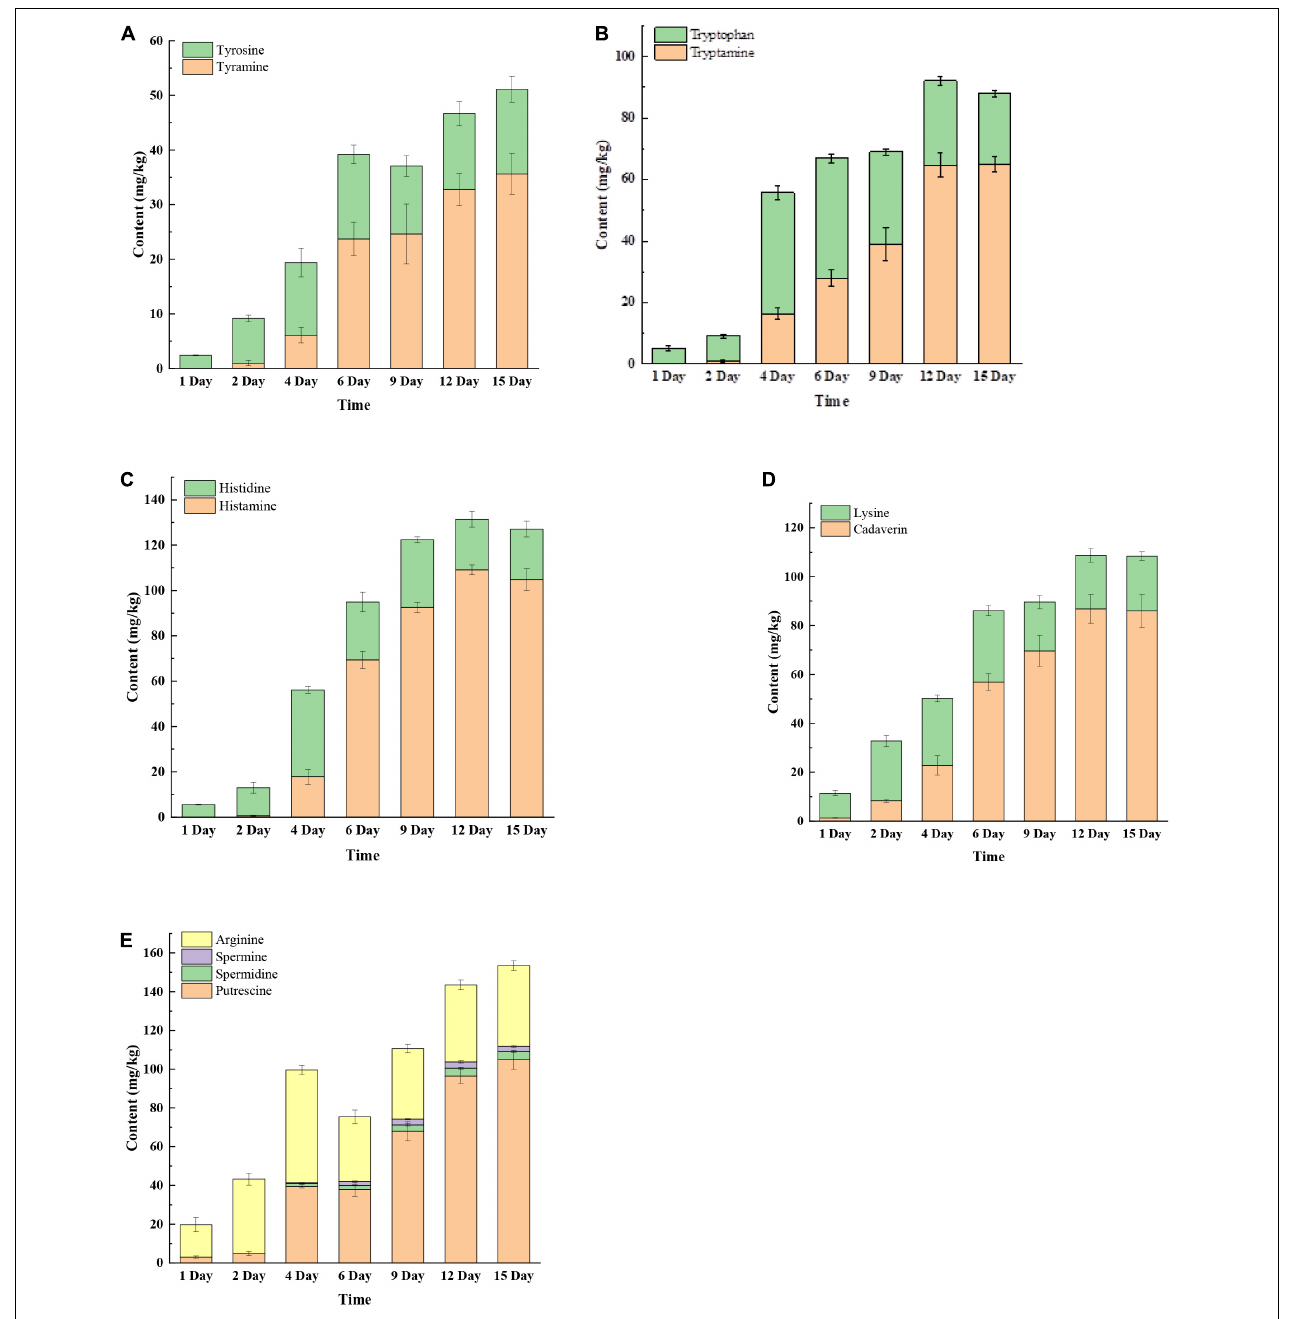
FIGURE 2 | The changes of biogenic amines (BAs) and BA precursor amino acids at different fermentation times. (A) Tyrosine and tyramine; (B) tryptophan and tryptamine; (C) histidine and histamine; (D) lysine and cadaverine; (E) putrescine, spermidine, spermine, and arginine.